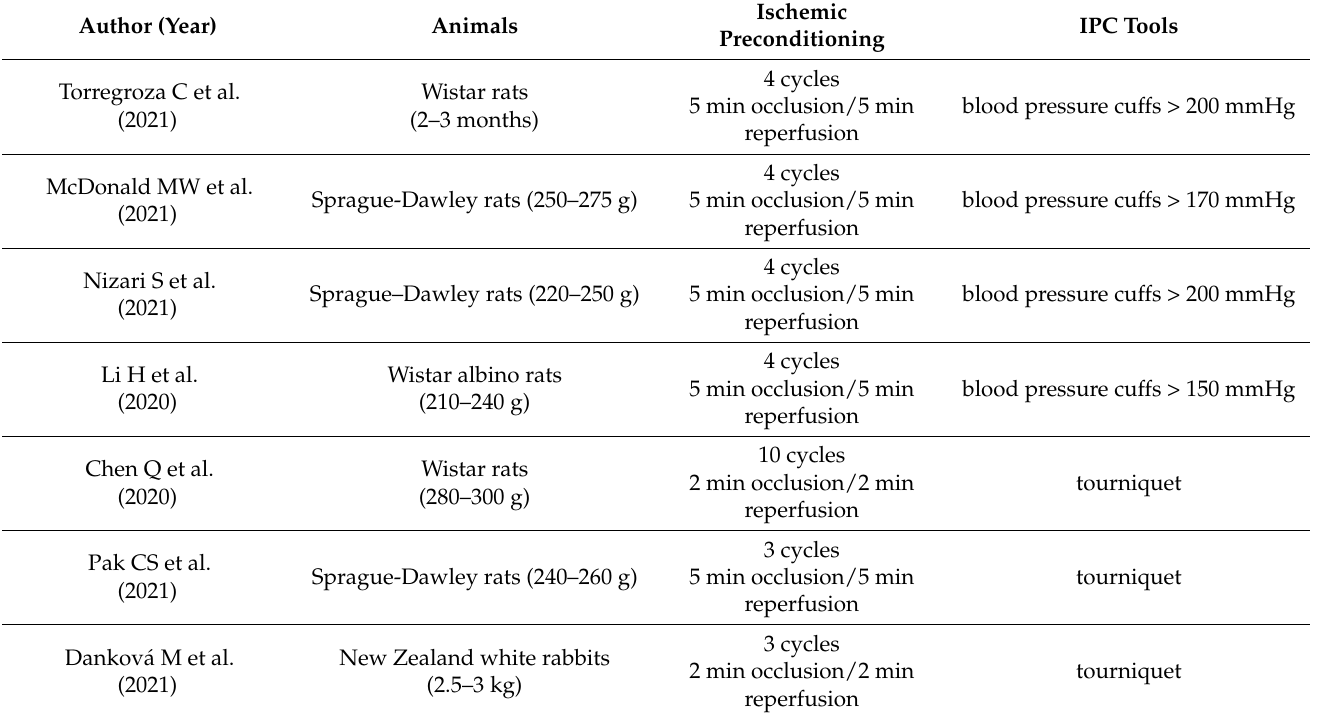
Table 5. Hind limb ischemic preconditioning animal model.